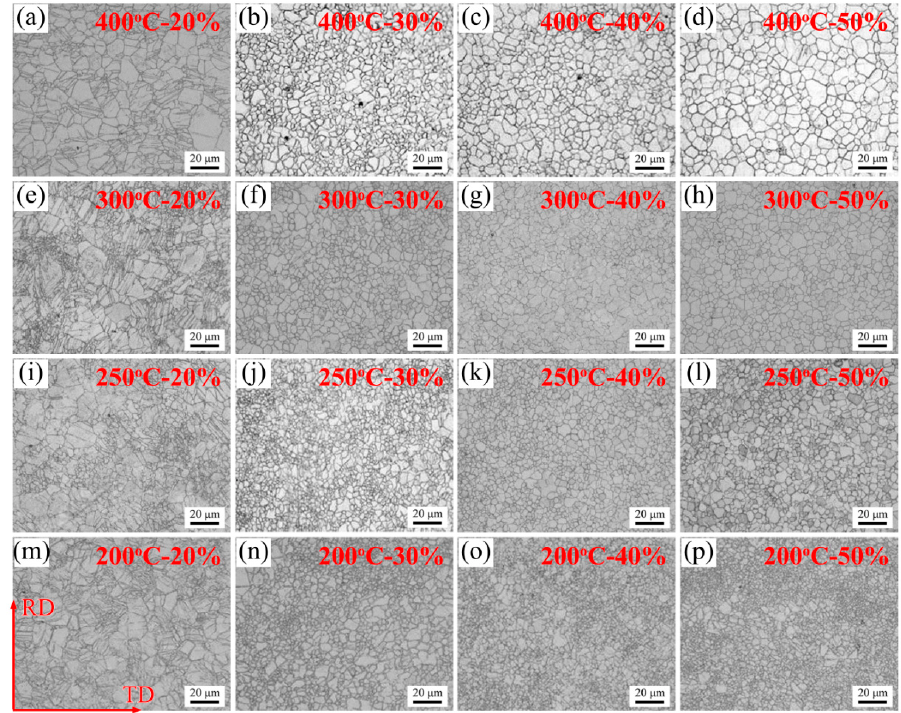
Figure 2. Metallographic observations of AZ31 magnesium alloy sheets under different rolling process parameters: ( a ) 400 ◦ C—20%, ( b ) 400 ◦ C—30%, ( c ) 400 ◦ C—40%, ( d ) 400 ◦ C—50%, ( e ) 300 ◦ C—20%, ( f ) 300 ◦ C—30%, ( g ) 300 ◦ C—40%, ( h ) 300 ◦ C—50%, ( i ) 250 ◦ C—20%, ( j ) 250 ◦ C—30%, ( k ) 250 ◦ C—40%,